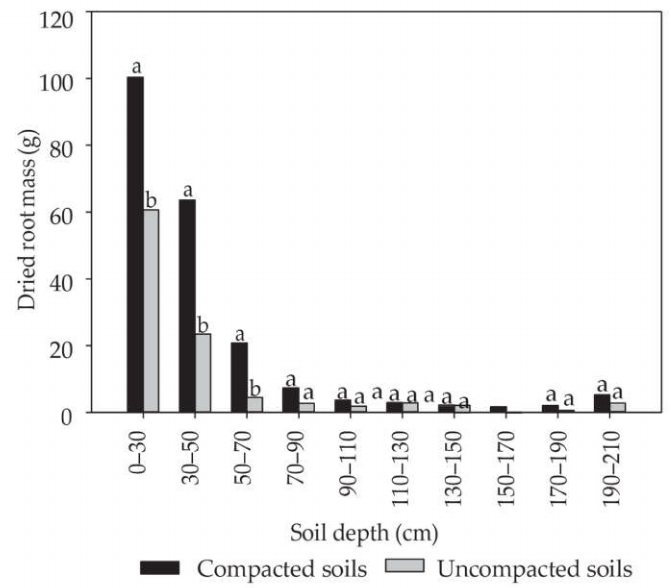
Figure 6. Rare positive correlation of soil compaction and root biomass. Different letters for the same depth indicate significant differences in root biomass (ab—Significant difference in root biomass and aa-No significant differences)